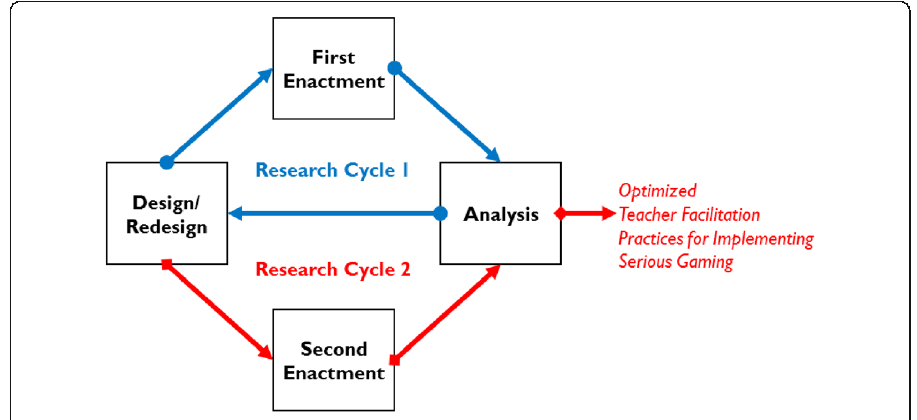
Fig. 1 Two-cycle DBR